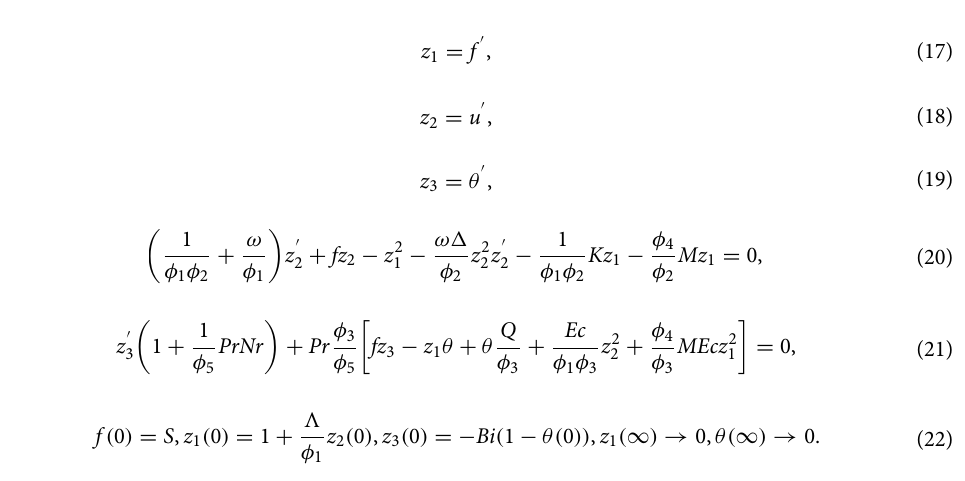
Figure 3. Net rectangle for difference